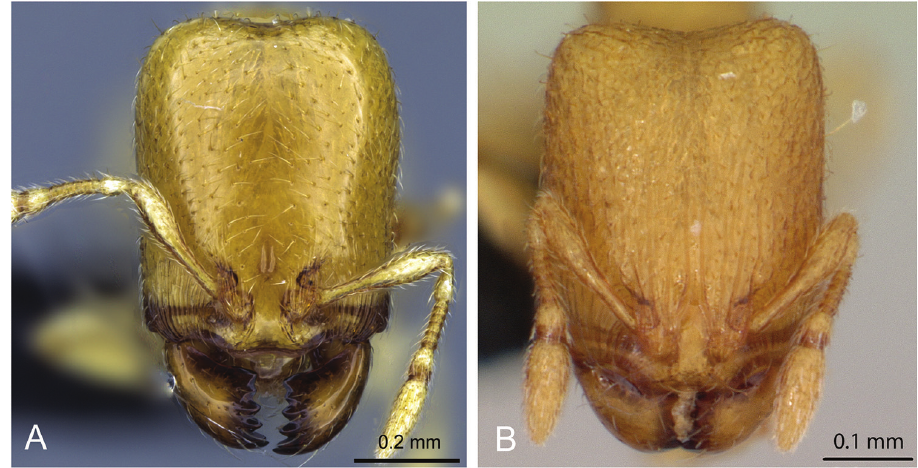
Figure 4. Head in full-face view of A Carebara grandidieri (CASENT0444653) B Carebara creolei